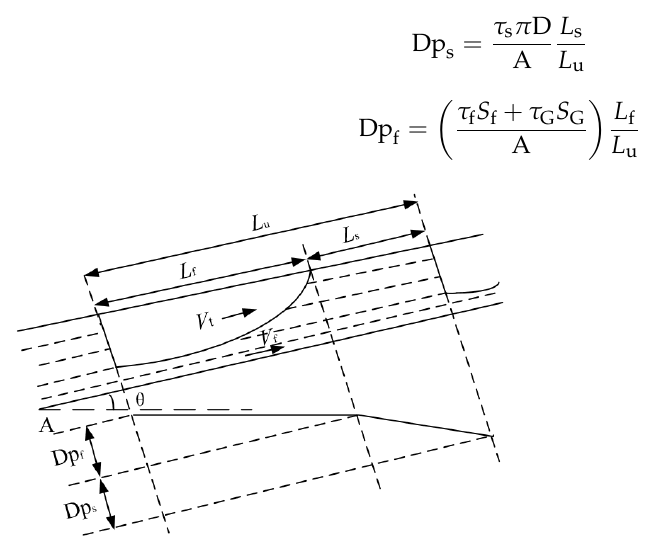
Figure 4. Pressure drop of slug flow unit.